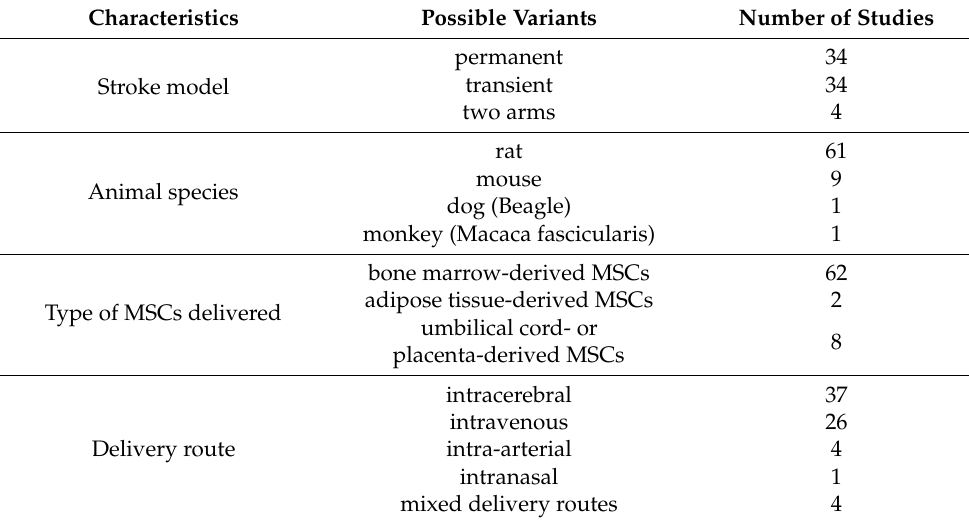
Table 2. Overview of the characteristics reported in the studies included by Lalu et al. in their meta-analysis of pre-clinical trials with mesenchymal stem cells (MSCs) for ischemic stroke.